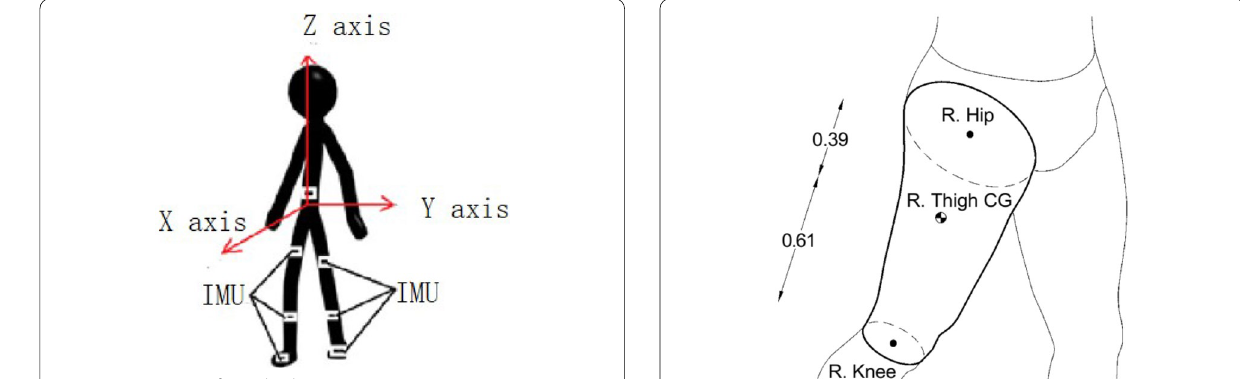
Figure 5 Position of attached sensors